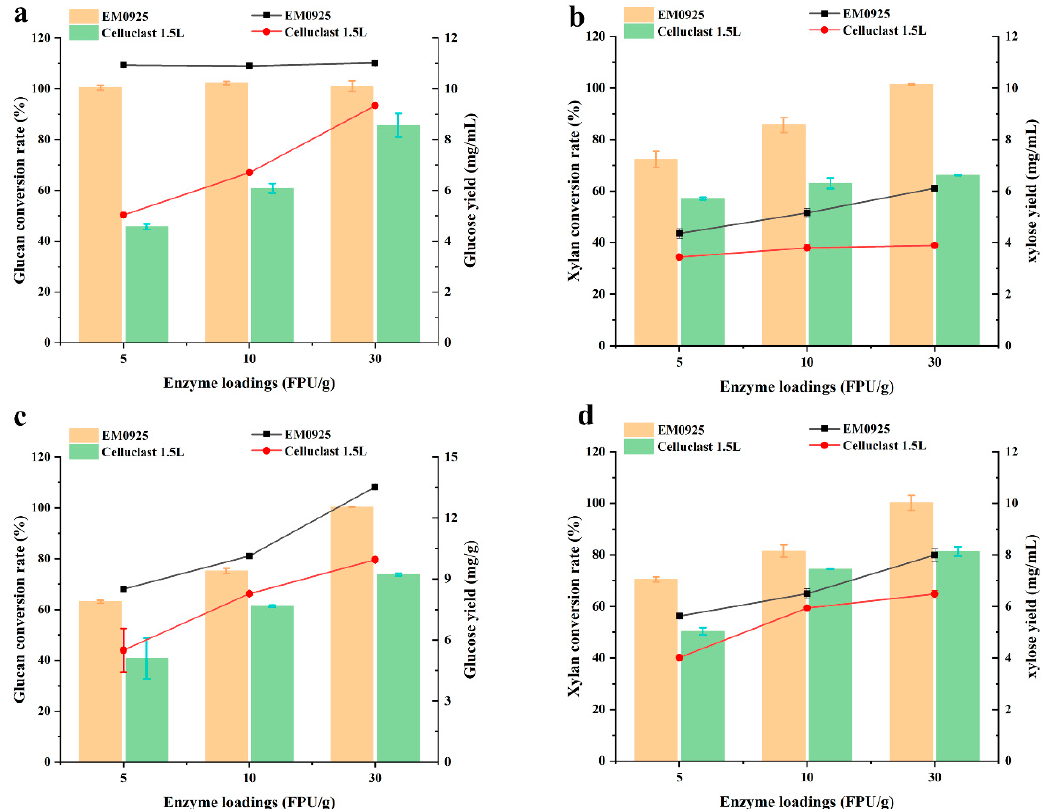
Figure 6. Conversion of glucan and xylan and sugar yield from UGCS and ALKCS by commercial enzyme preparation and T. harzianum EM0925 enzyme cocktails. ( a ) Glucan conversion and glucose yield from UGCS by commercial and T. harzianum EM0925 enzyme cocktails; ( b ) xylan conversion and xylose yield from UGCS by commercial and T. harzianum EM0925 enzyme cocktails; ( c ) glucan conversion and glucose yield from ALKCS by commercial and T. harzianum EM0925 enzyme cocktails; ( d ) xylan conversion and xylose yield from ALKCS by commercial and T. harzianum EM0925 enzyme cocktails. Celluclast 1.5 L, commercial cellulase preparation; UGCS, ultrafine grinding corn stover; ALKCS, sodium hydroxide treated corn stover.